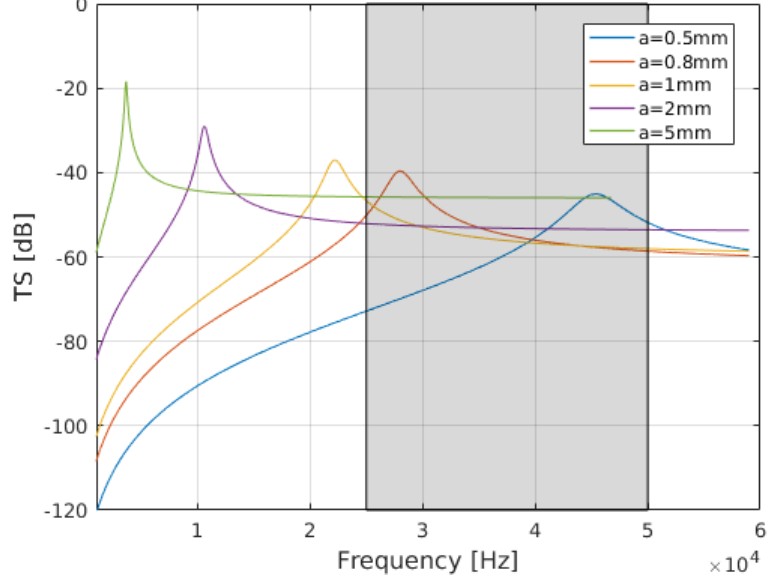
Figure 1. Target strength (TS) of an air-filled sphere at 500 m depth. The gray shaded area indicates the bandwidth of the EK80 split-beam transducer used in this study (25 to 50 kHz). Bubbles with a radii of approximately 0.5 mm to 0.9 mm are resonant within this frequency range. For the seeps studied here we expect predominately bubble sizes of approximately 1–5 mm radius, thus scattering above